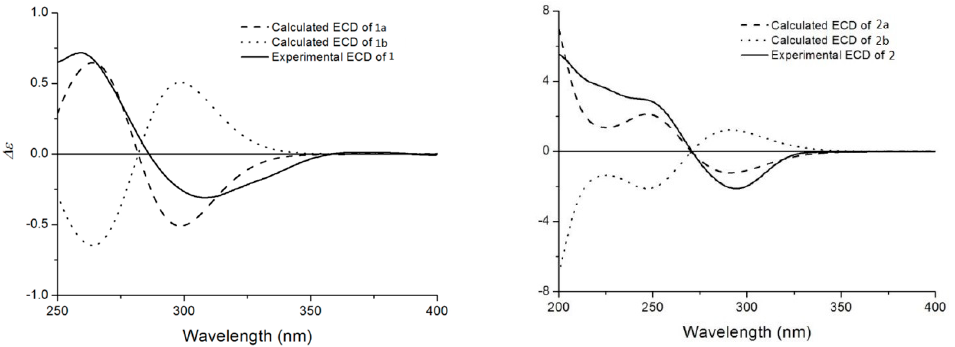
Figure 3. Calculated and experimental ECD spectra for 1 and 2 in